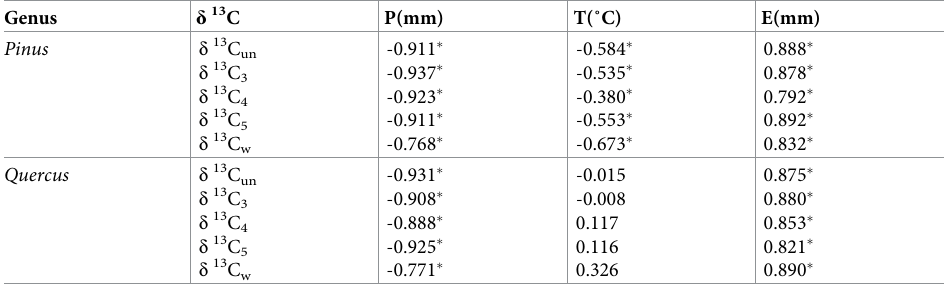
Table 4. Pearson correlation coefficients(r) between δ 13 C (‰ VPDB) and climatic parameters of